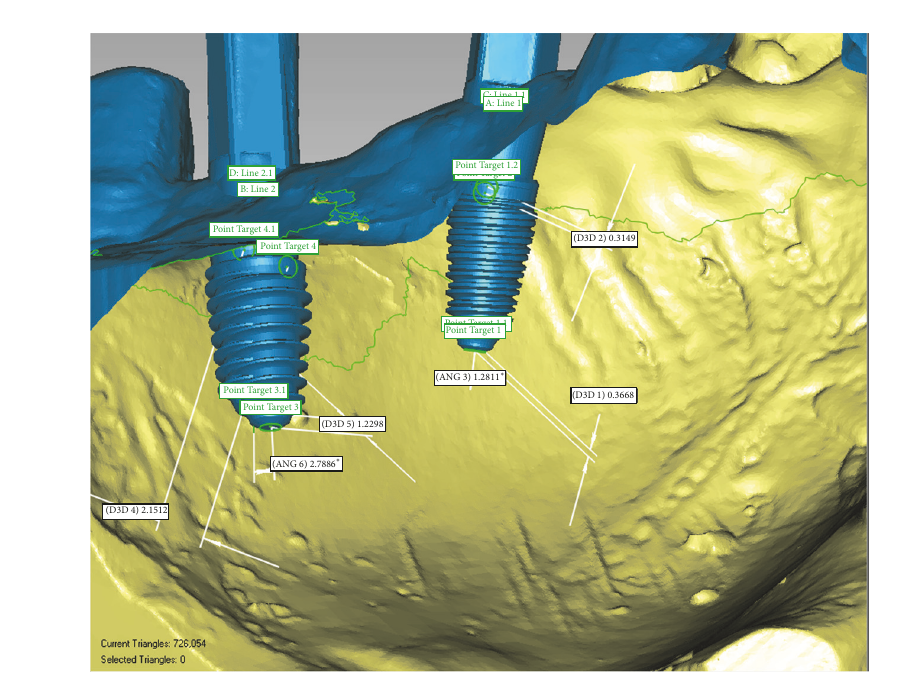
Figure 6: Study workflow.